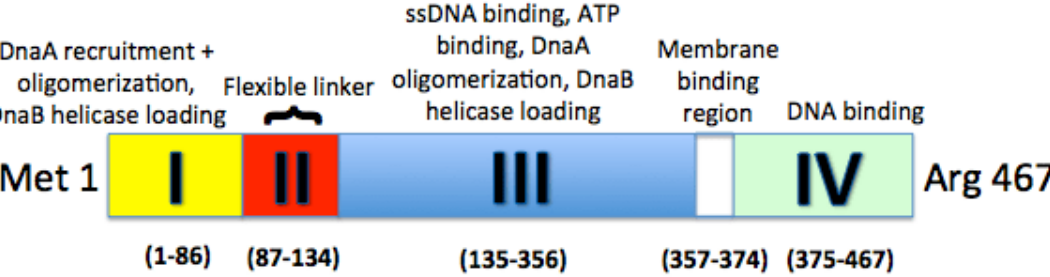
Figure 1. A schematic map of the four domains of DnaA. ssDNA: single-stranded DNA.